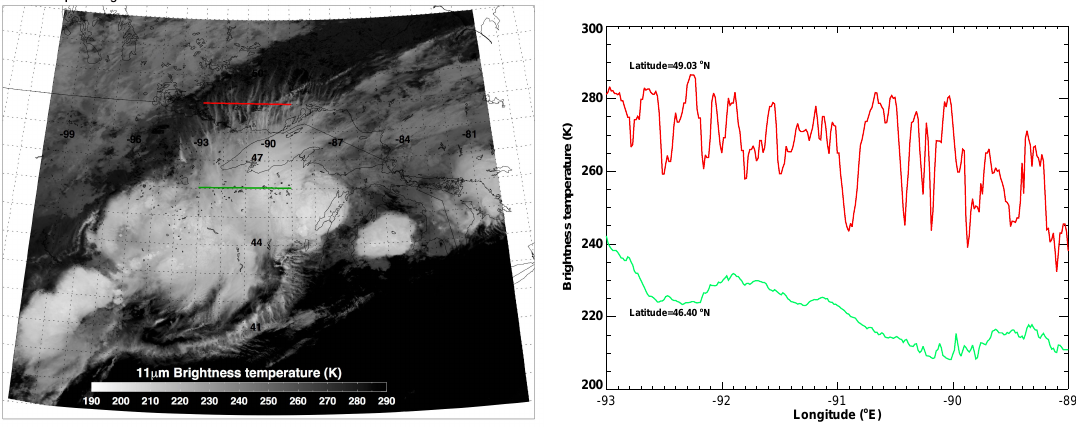
Figure 18. Left: MODIS/Aqua 11 µ m brightness temperature image showing a large cloud formation Figure 18. Left : MODIS/Aqua 11 µ m brightness temperature image and outflow cirrus clouds. Right: Temperature transects across the cloudy region and outflow region showing a large cloud formation and outflow cirrus clouds. Right : (red) showing a high temperature variation across the outflow Temperature transects across the cloudy region and outflow region (red) showing a high temperature variation across the outflow region.